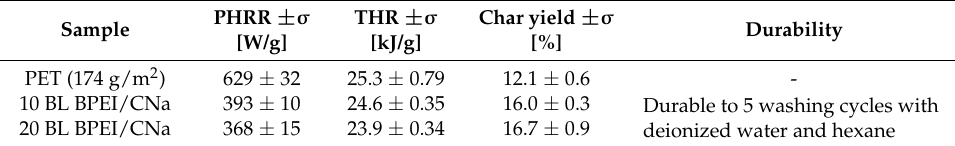
Table 9. PCFC data and durability performances for PET treated by BPEI/CNa LbL coating [45].